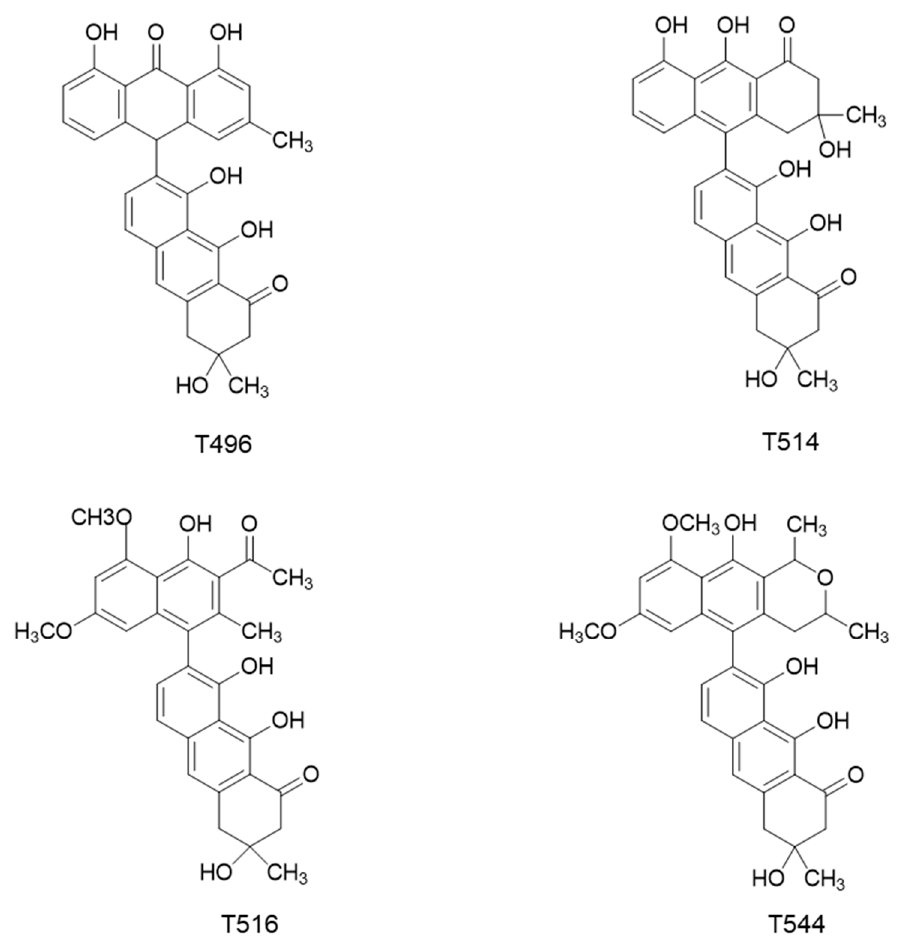
Figure 1. Chemical structures of the four toxins isolated from K. humboldtiana .